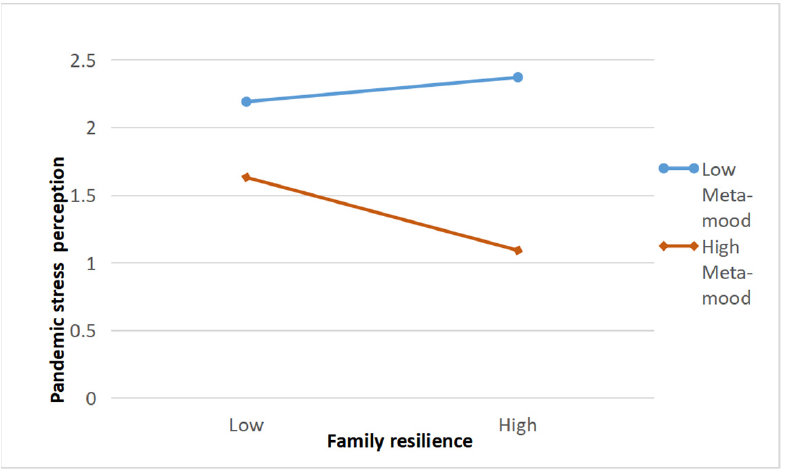
Figure 4. The moderating effect of meta-mood on the relationship between family resilience and pandemic stress perception.